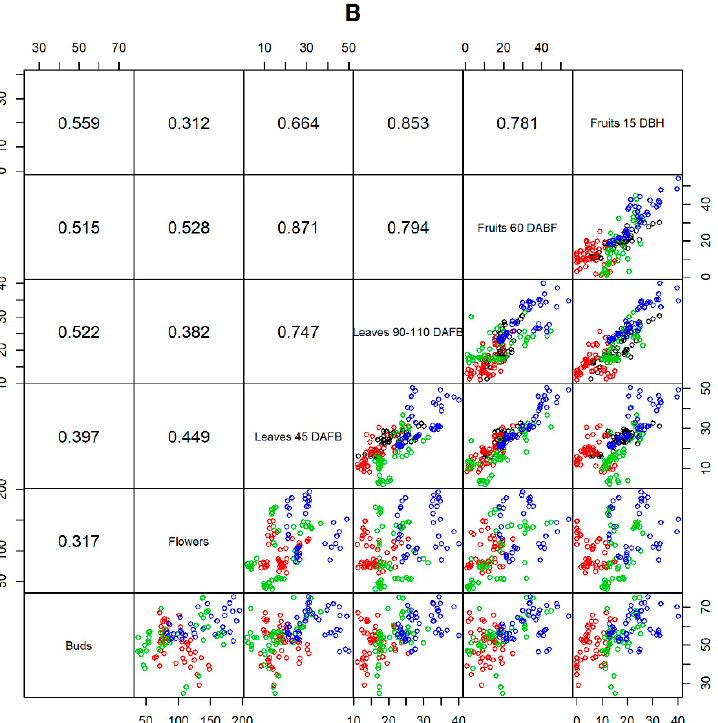
Figure 2. Matrix of scatterplots of boron content (mg kg − 1 DW) between pairs of organs ( n = 180). The scatterplot in line i and column j (j > i) contains boron content in organ i plotted against boron content in organ j. Each color corresponds to a year: black for 2018, red for 2019, green for 2020 and blue for 2021. The upper panel displays the corresponding Pearson correlation coefficients, where line i and column j (i > j) contain the correlation between boron content in organs i and j. All correlations are significantly different from zero ( p < 0.05).